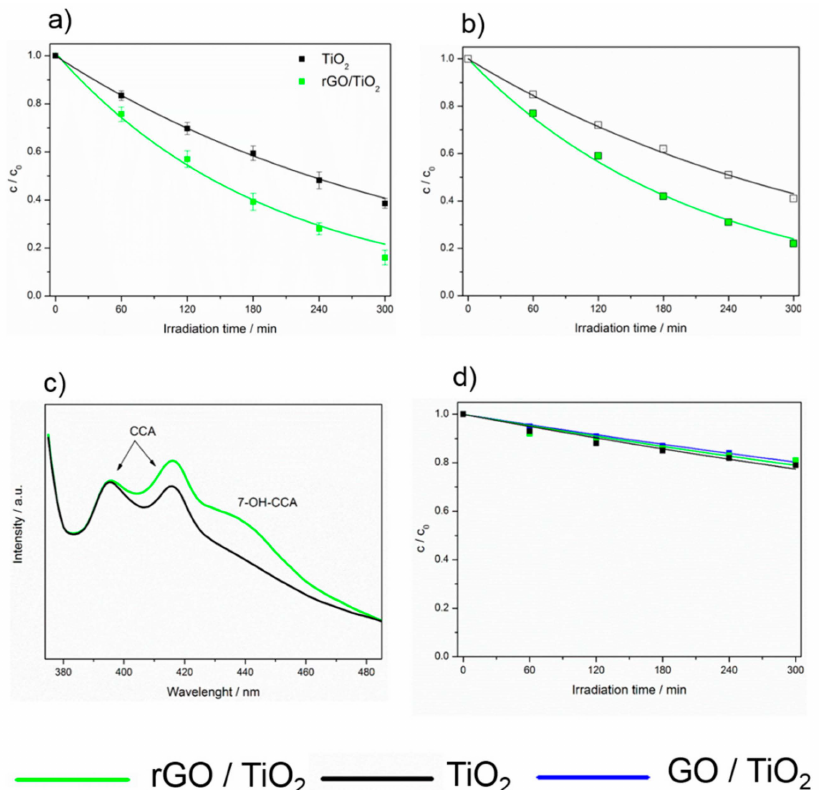
Figure 3. ( a ) Course of the photocatalytic degradation of 4-chlorophenol on TiO 2 and rGO / TiO 2 photocatalysts, ( b ) reusability of TiO 2 and rGO / TiO 2 photocatalysts, ( c ) fluorescence spectra of 7-OH-coumarin-3-carboxylic acid after irradiation of TiO 2 and rGO / TiO 2 with 365 nm light